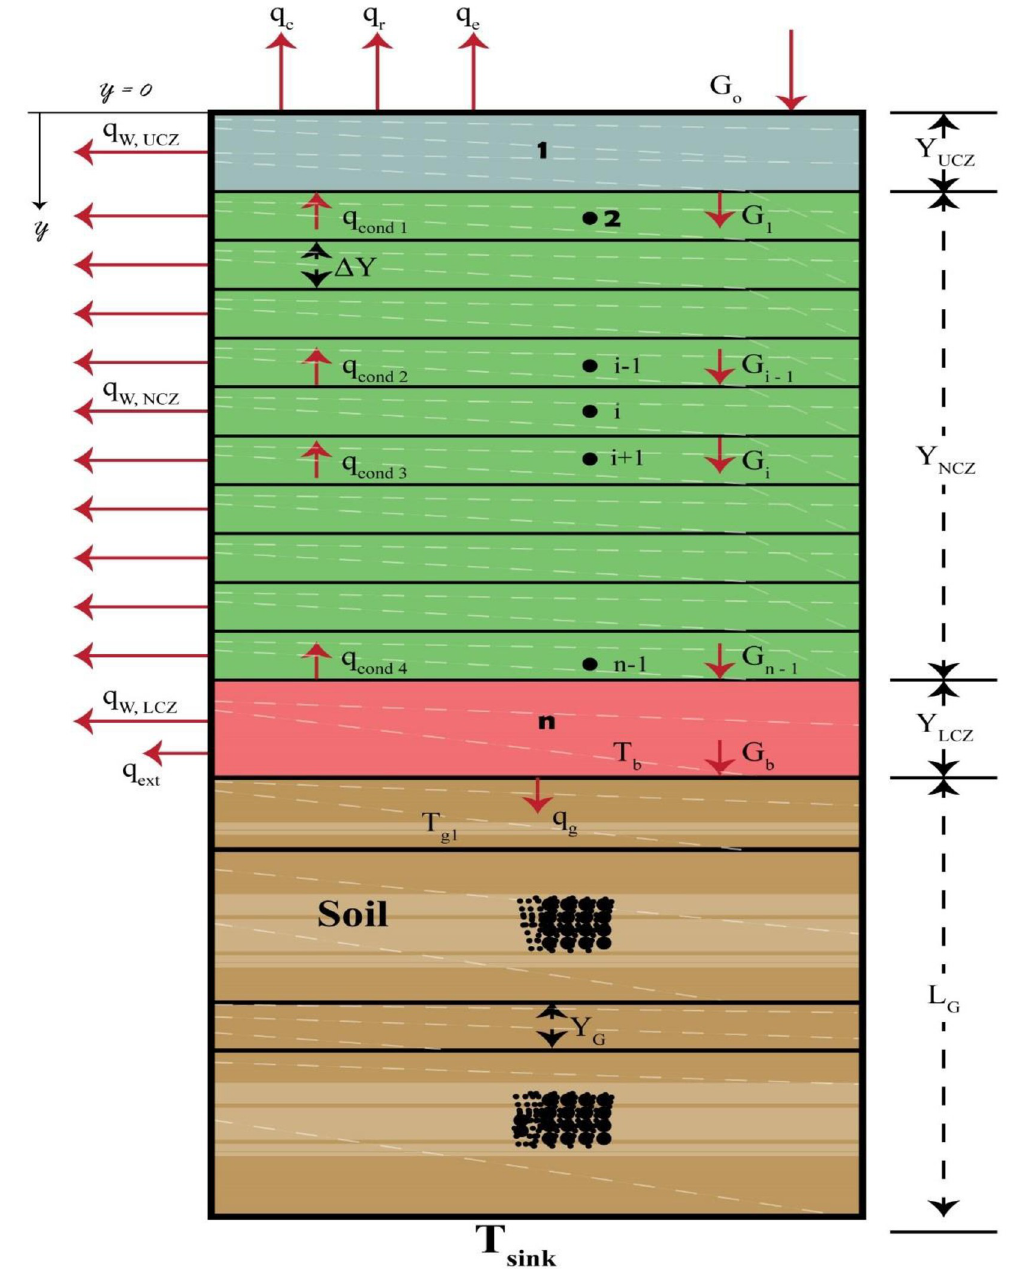
Fig 5. Mathematical models of solar pond and